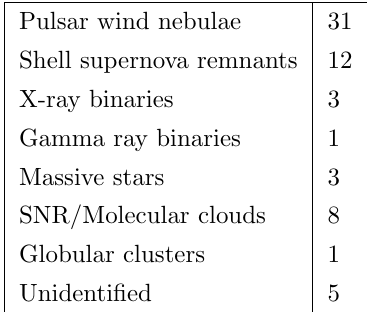
Pulsar wind nebulae